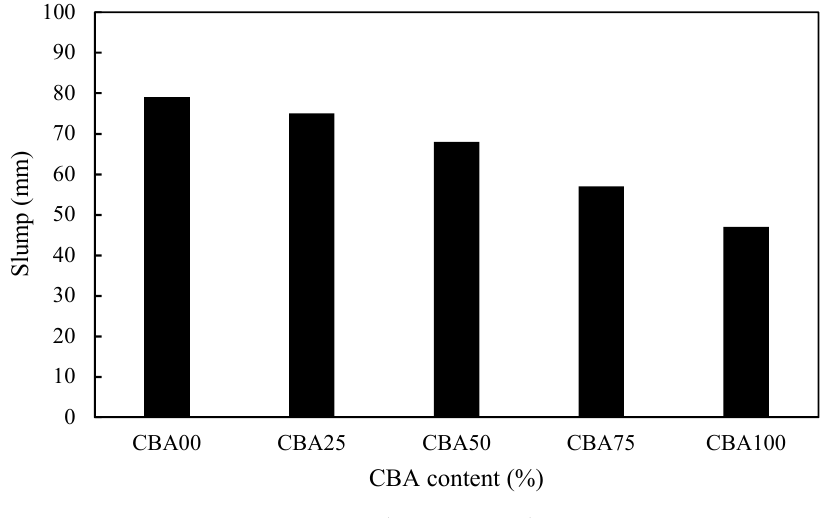
Figure 5. Slump test results.